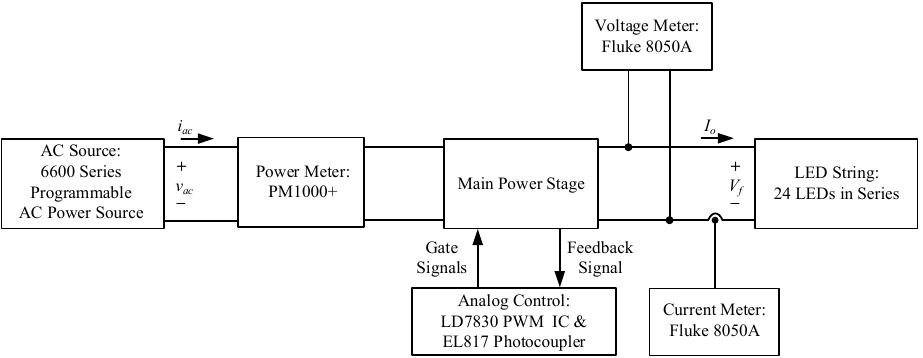
Figure 5. Test bench for measuring efficiency, PF, and total harmonic distortion (THD).